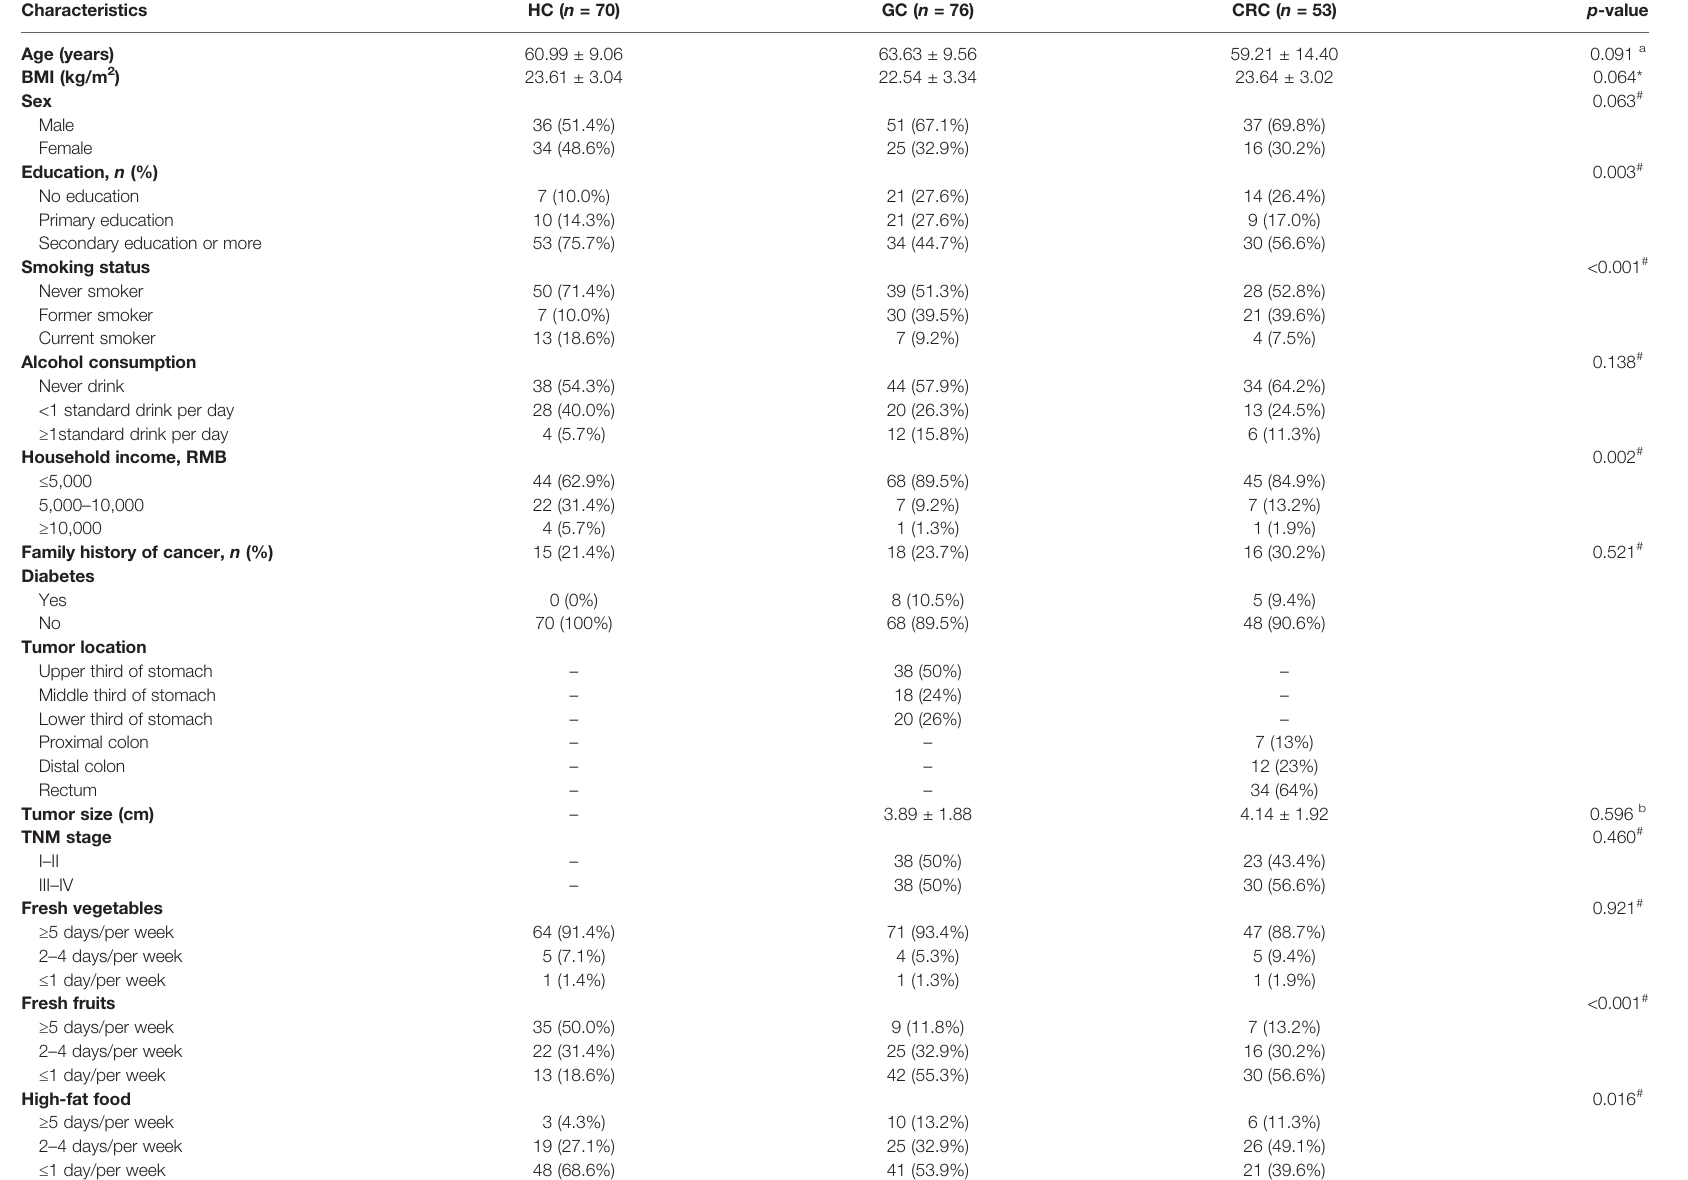
TABLE 1 | Clinical characteristics and diet information of the enrolled